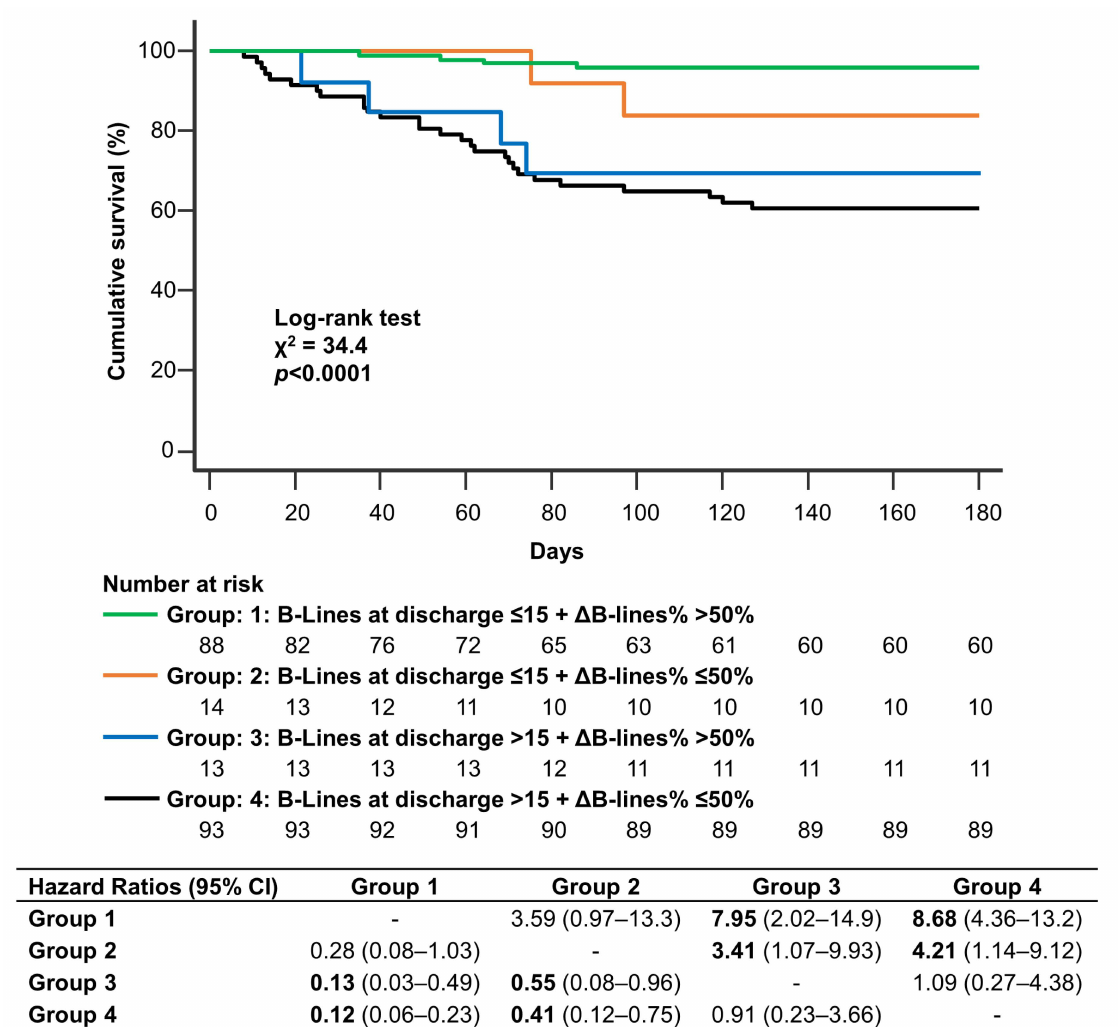
Figure 3. Kaplan-Meier survival analysis for the primary endpoint (cardiovascular death and rehos- pitalization for heart failure) according to B-lines at discharge and ∆ B-lines%. Patients are stratified in four groups according to B-lines at discharge (> 15 or ≤ 15) and ∆ B-lines% ( ≤ 50% or >50%). Numbers of patients at risk are shown below the survival curves. Pairwise comparison between groups is shown in accompanying table using hazard ratios and 95% confidence